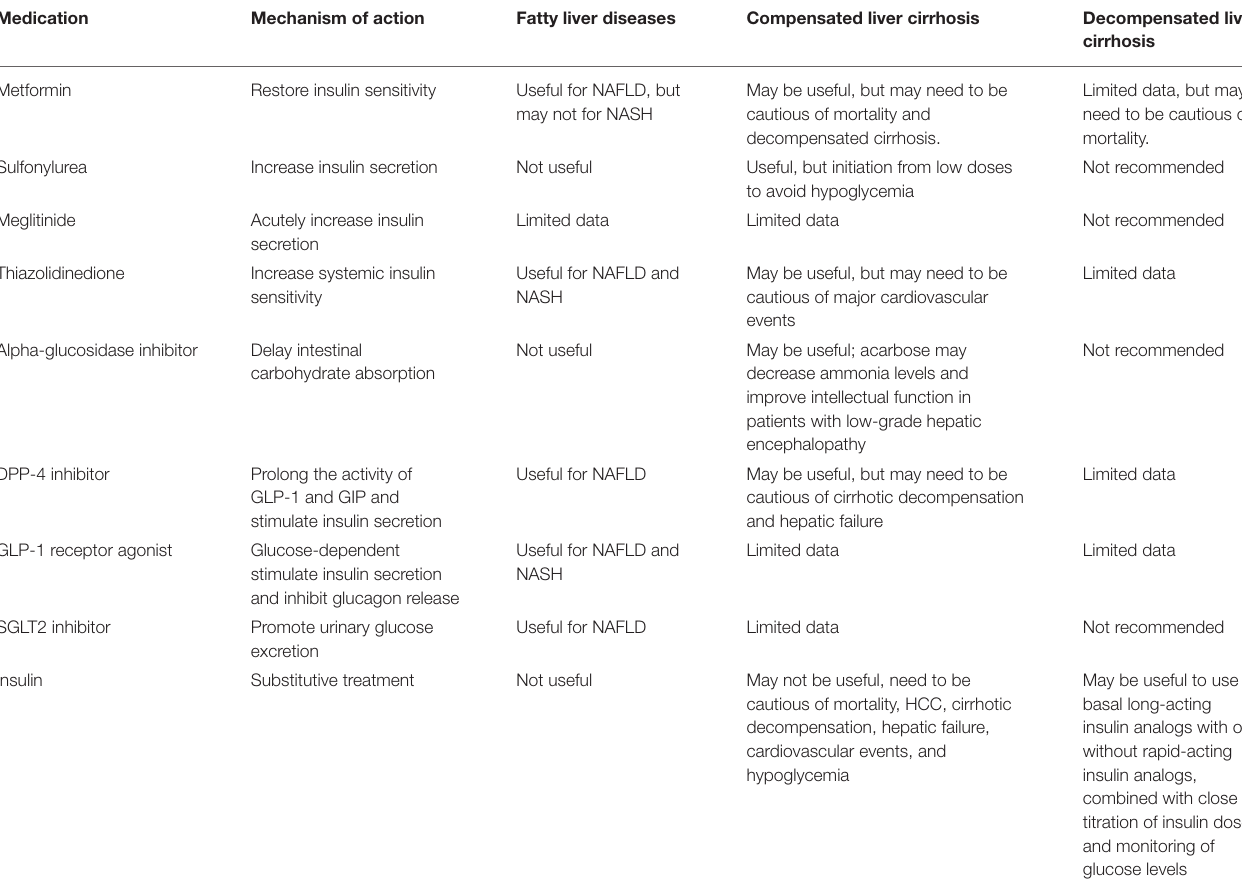
TABLE 2 | The usefulness and warning of antidiabetic medications in patients with chronic liver